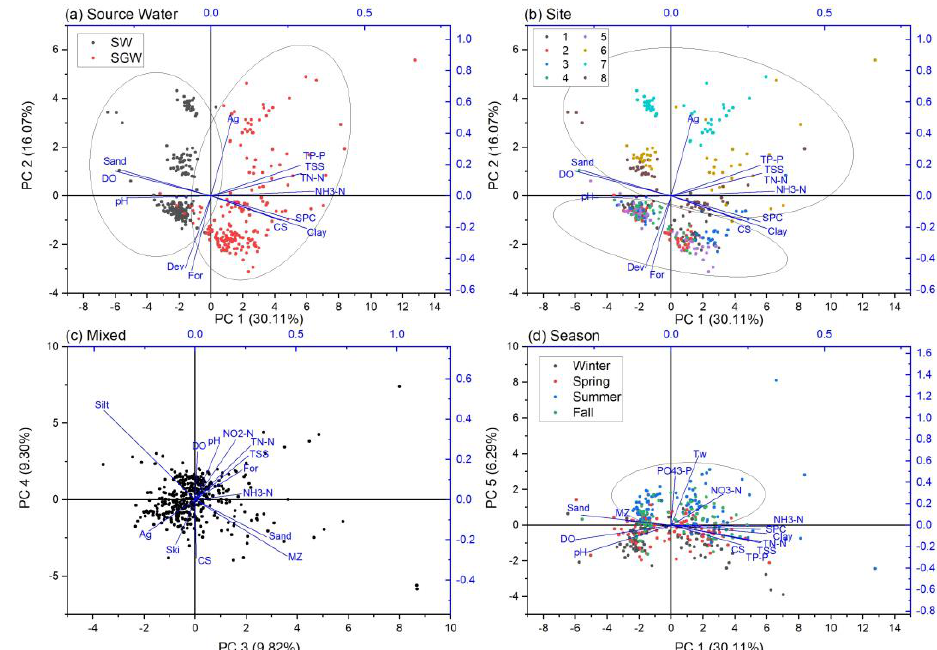
Figure 6. Results of a principal components analysis, including biplots and scores plots for extracted principal components of land use percent [Agriculture (Ag;%), Forest (For,%), and Developed (Dev,%)], nutrient concentrations (mg L − 1 ), suspended sediment characteristics [total suspended solids; TSS (mg L − 1 ), mean particle size; MZ ( µ m), calculated surface area; CS (m2 mL − 1 ), skewness; Ski, Sand (%), Silt (%), and Clay (%)], and physicochemical variables [water temperature (Tw; ◦ C), dissolved oxygen (DO; % saturation), specific conductance (SPC; µ s cm − 1 ), and pH] from surface water and shallow groundwater collected during the study period (January 2020 − December 2021) for eight monitoring sites in Moore’s Run, Watershed, WV, USA. Note: axes scales have been adjusted to maximize